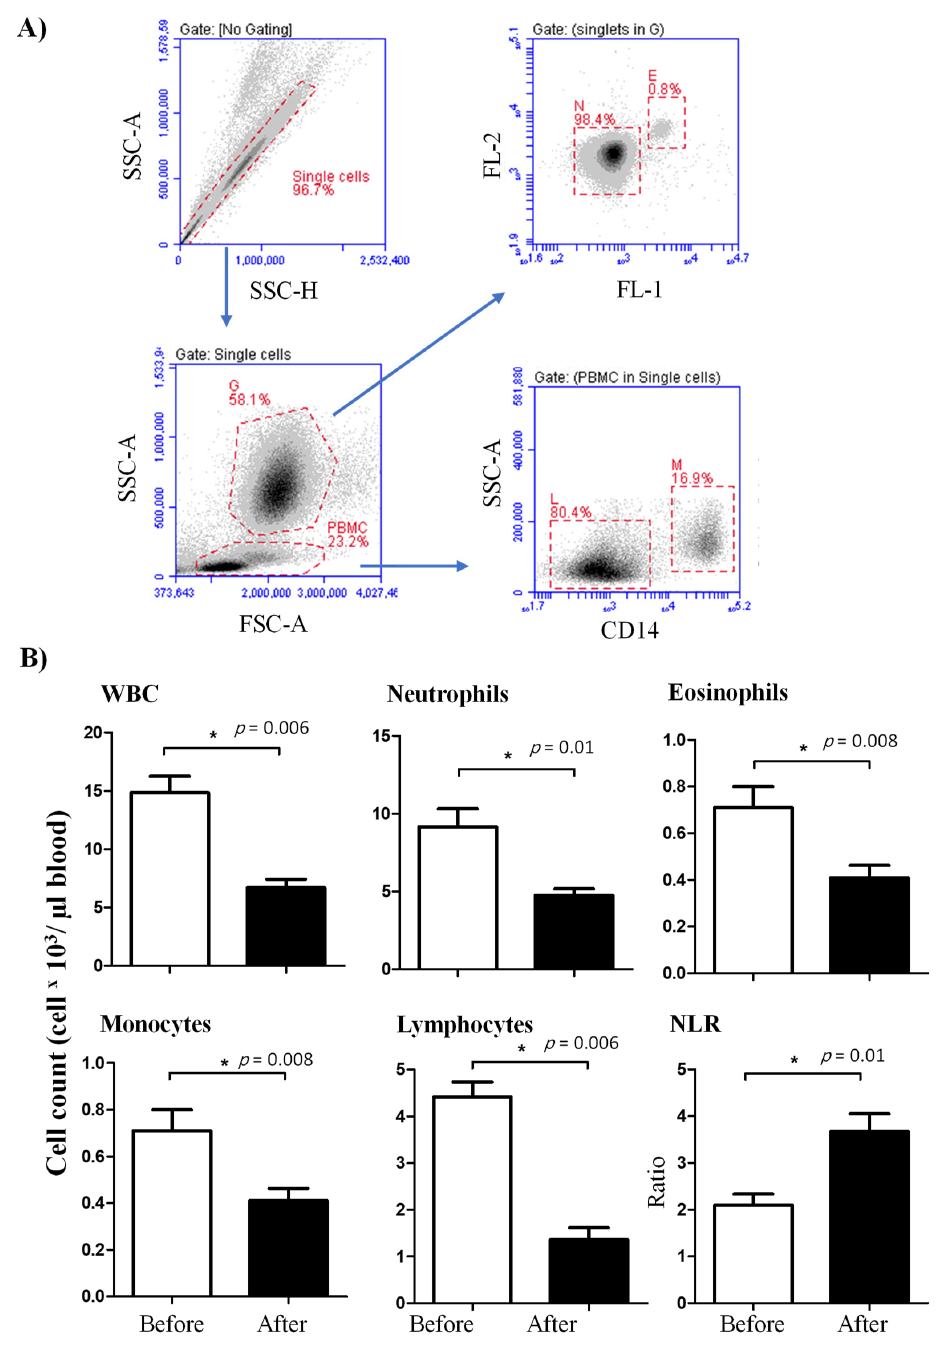
Figure 1. Ex vivo analysis of the leukogram of lornoxicam-treated camels. ( A ) Flow cytometric gating strategy for the analysis of leukocyte subpopulations. Doublets were excluded in a side scatter height (SSC-H) against SSC-Aria (SSC-A). In a SSC-A against forward scatter (FSC)-A dot plot, granulocytes (G) and peripheral blood mononuclear cells (PBMC) were identified based on their scatter characteristics. Based on their different autofluorescence intensities in the green FL-1 channel, eosinophils (E) were distinguished from neutrophils (N) [25] . Monocytes (M) and lymphocytes (L) were identified as CD14-positive and CD14-negative PBMC, respectively. ( B ) Whole white blood cells (WBC) were counted under the microscope after erythrolysis using Turk solution. The cell numbers of leukocyte populations were estimated by multiplication their percentages in blood leukocytes with the absolute number of WBC. Mean cell numbers and standard error of the mean were presented for all leukocyte subsets before and after treatment. Differences between the means were considered significant (*) if p < 0.05 .